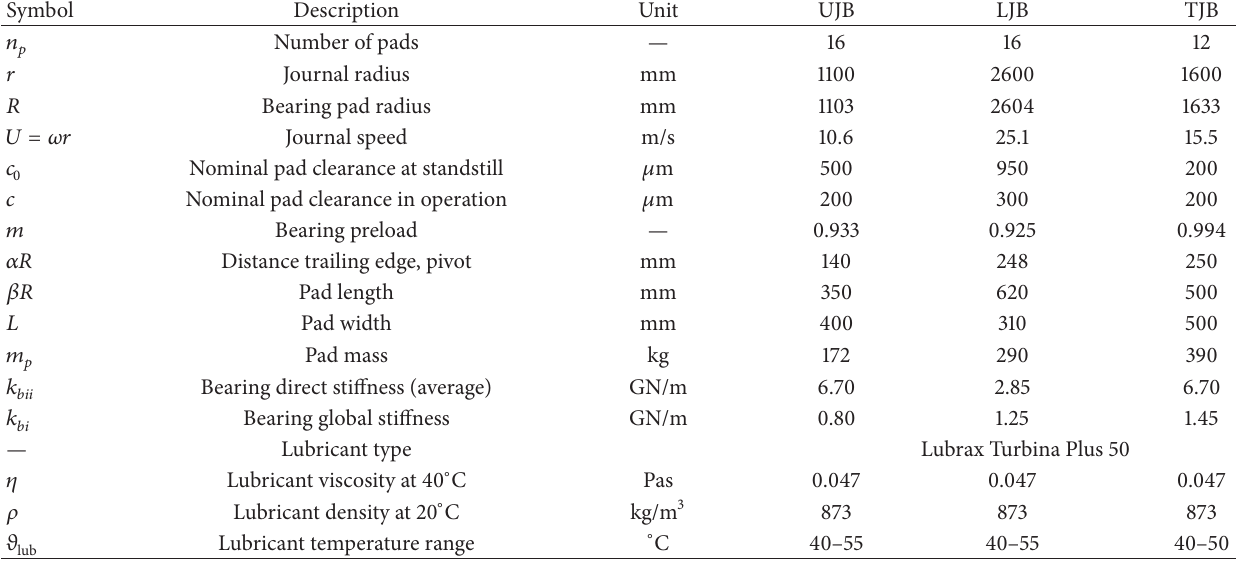
Table 1: Main data of the generator upper journal bearing (UJB), generator lower journal bearing (LJB), and turbine journal bearing